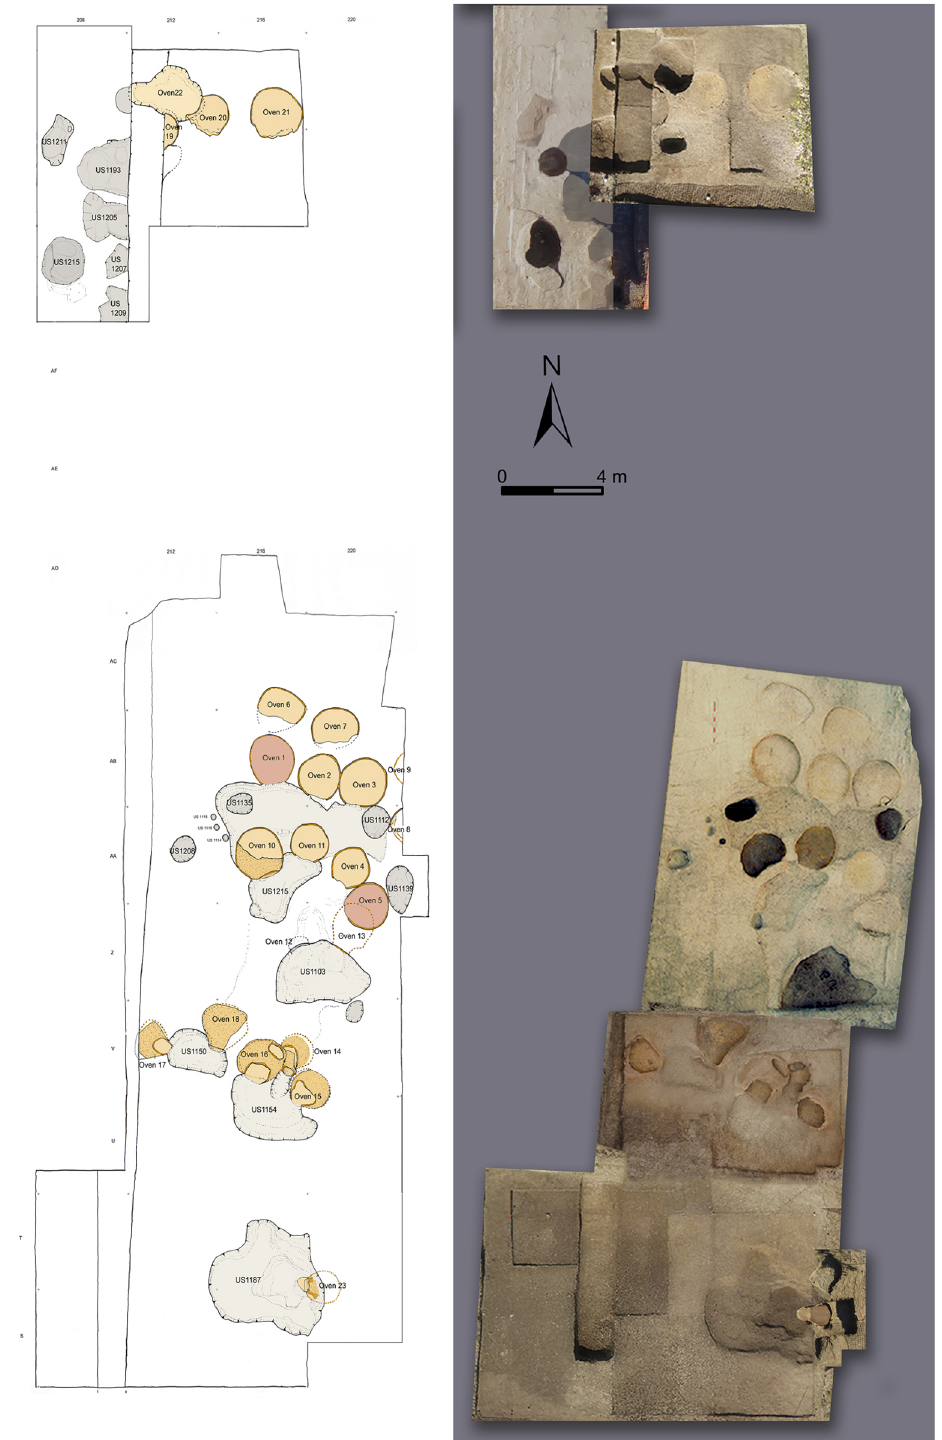
Figure 2: Portonovo ( Marche, Italy ) . General map and aerial view of the archaeological site. ( © Portonovo Project; map and photo have the same scale )